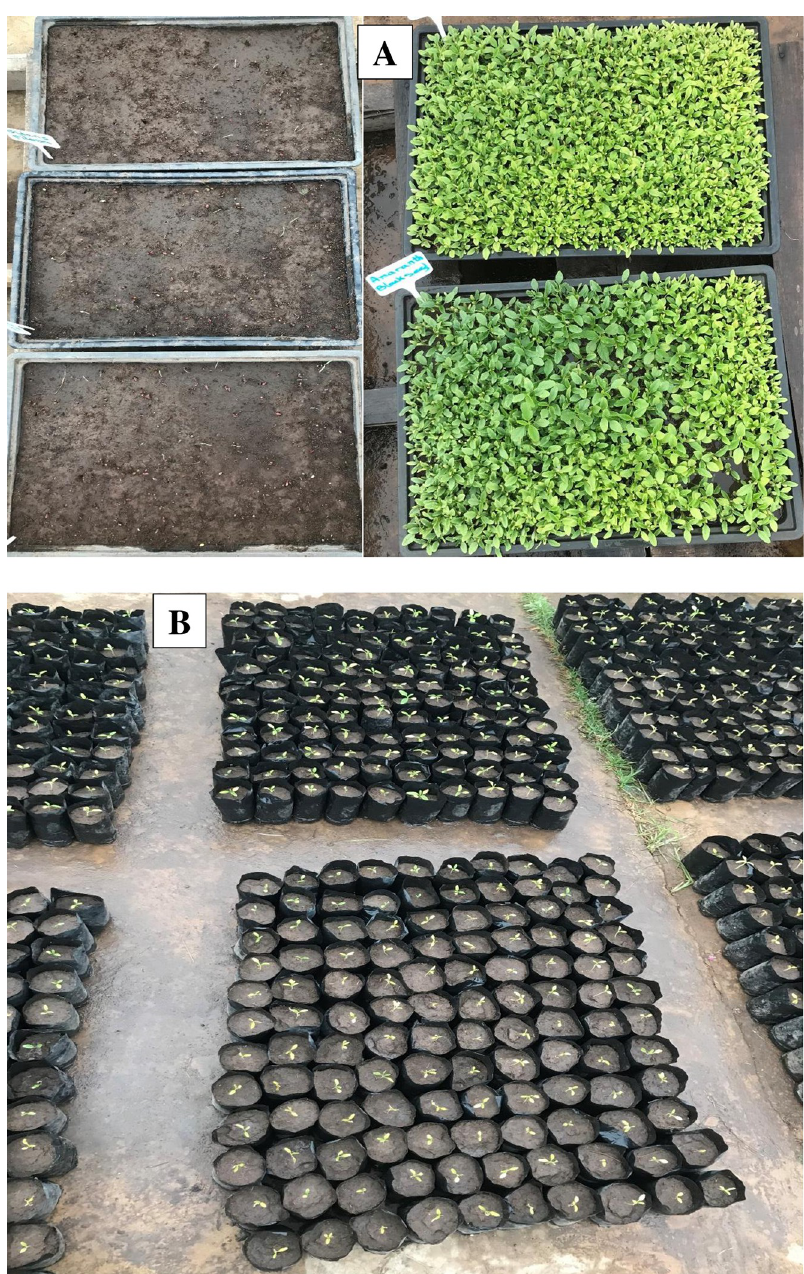
Fig 1. Images illustrating the germination assay in plastic trays (A) and seedlings transplanted in small pots for experimental treatments (B).